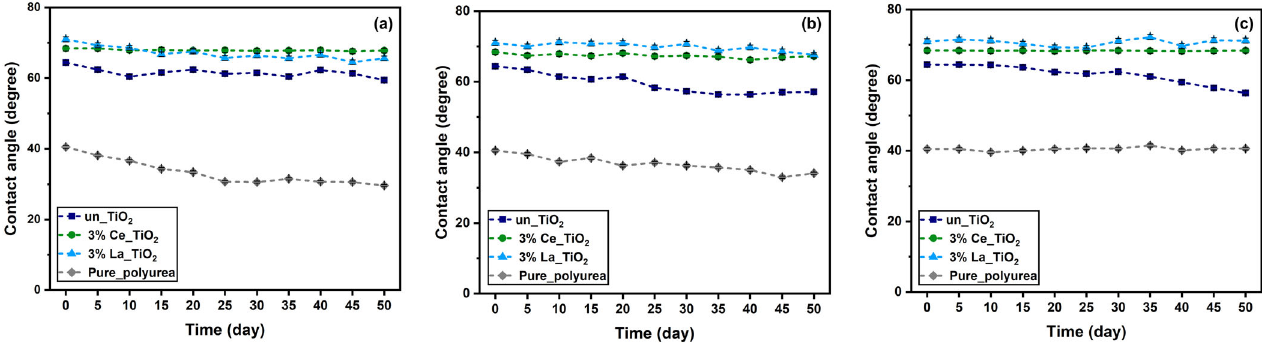
Fig. 4 Surface wettability variability for continuous 50 days in three different chemicals. a Hydrochloric acid (acid), b sodium hydroxide (alkaline), and c sodium chloride (saline)